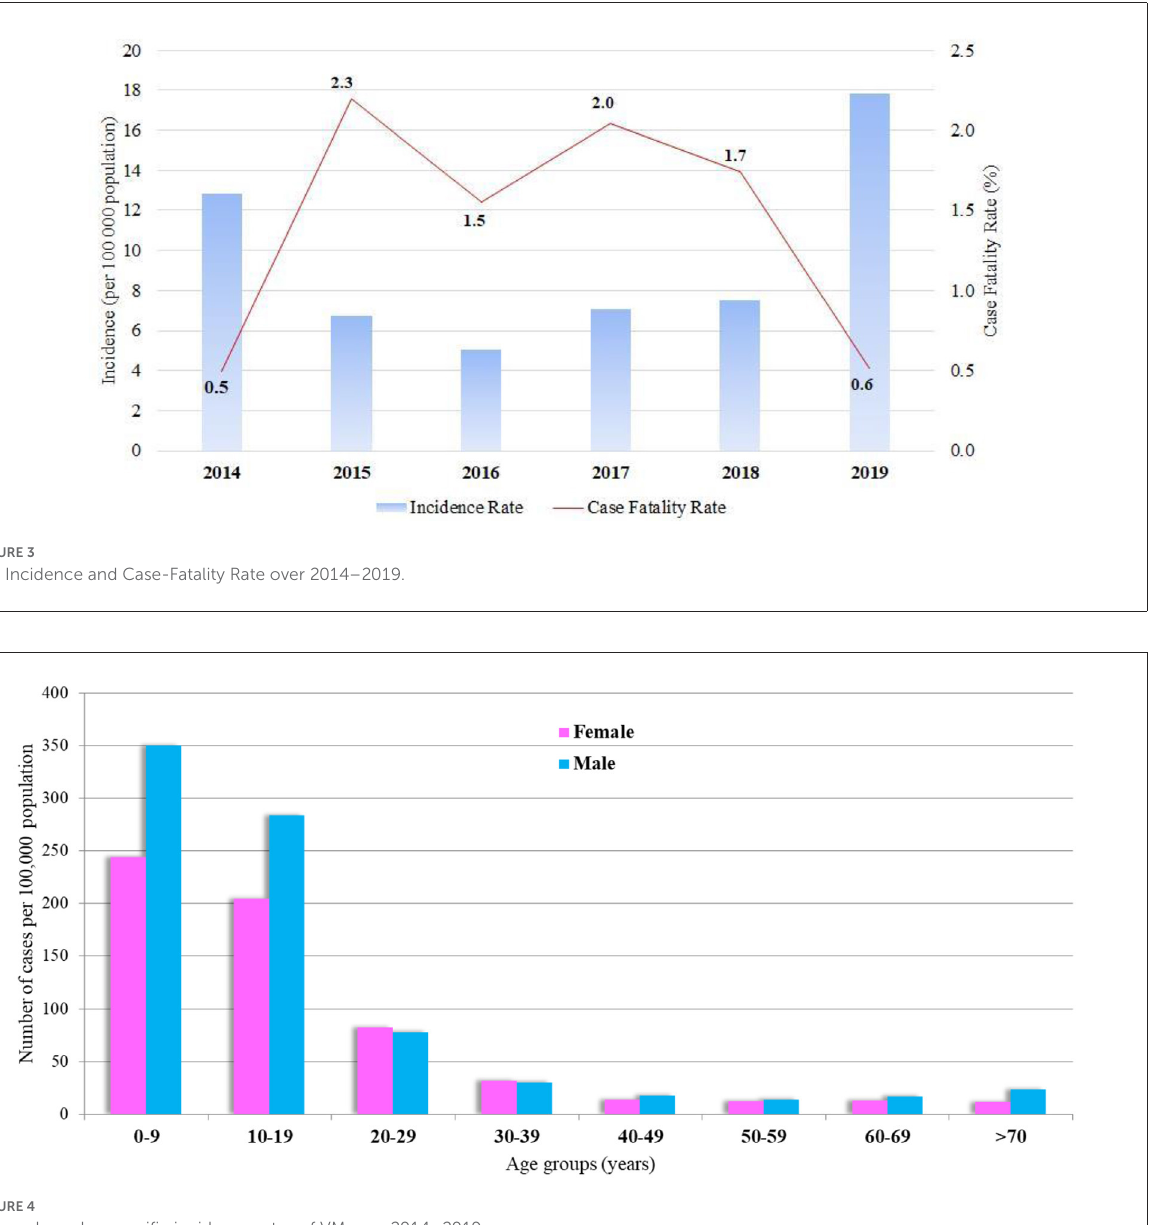
trend among children and adults (Supplementary Figure